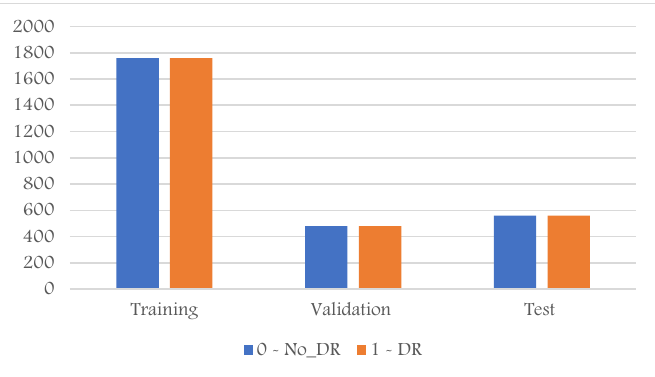
Figure 4. DR dataset distribution after converting it into binary categories (normal, abnormal).